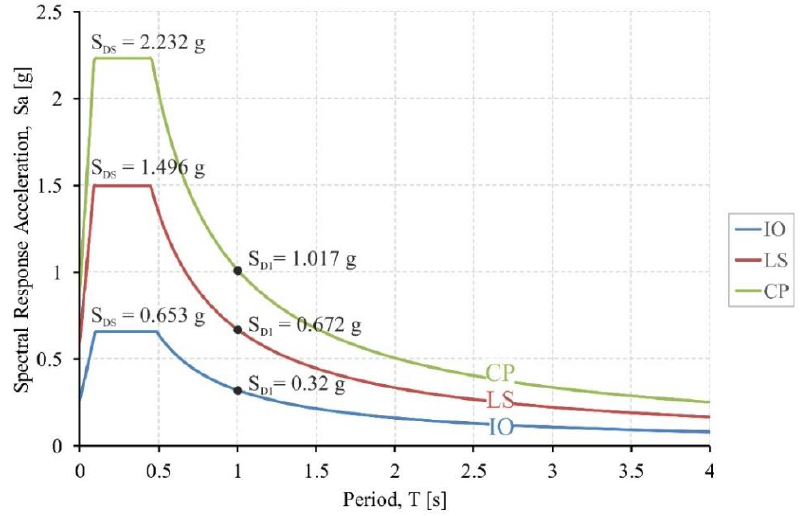
Figure 5. Design acceleration response spectra for Eureka (CA, USA), in accordance with [5] .